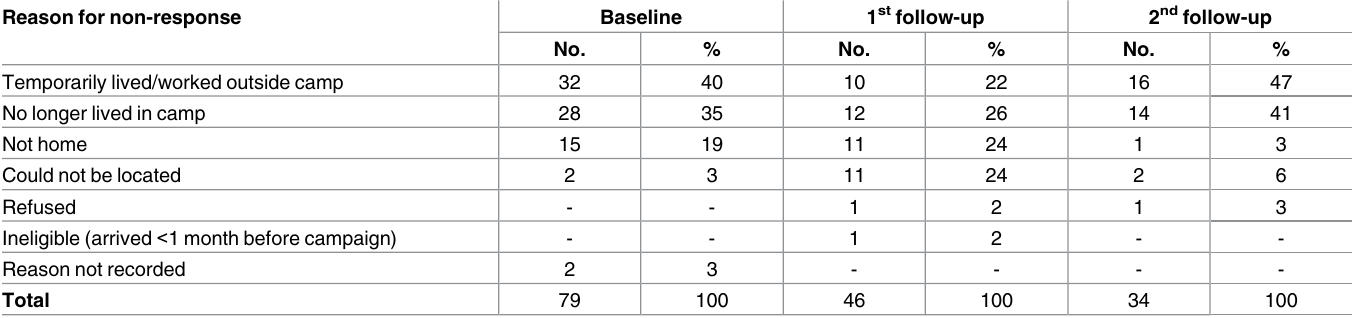
Table 1. Reasons for household non-response in the surveysconducted 1 month before (baseline), and 3 and 12 months after (first and second follow-up) an oral cholera vaccination campaign, Maela Camp, 2013. Reason for